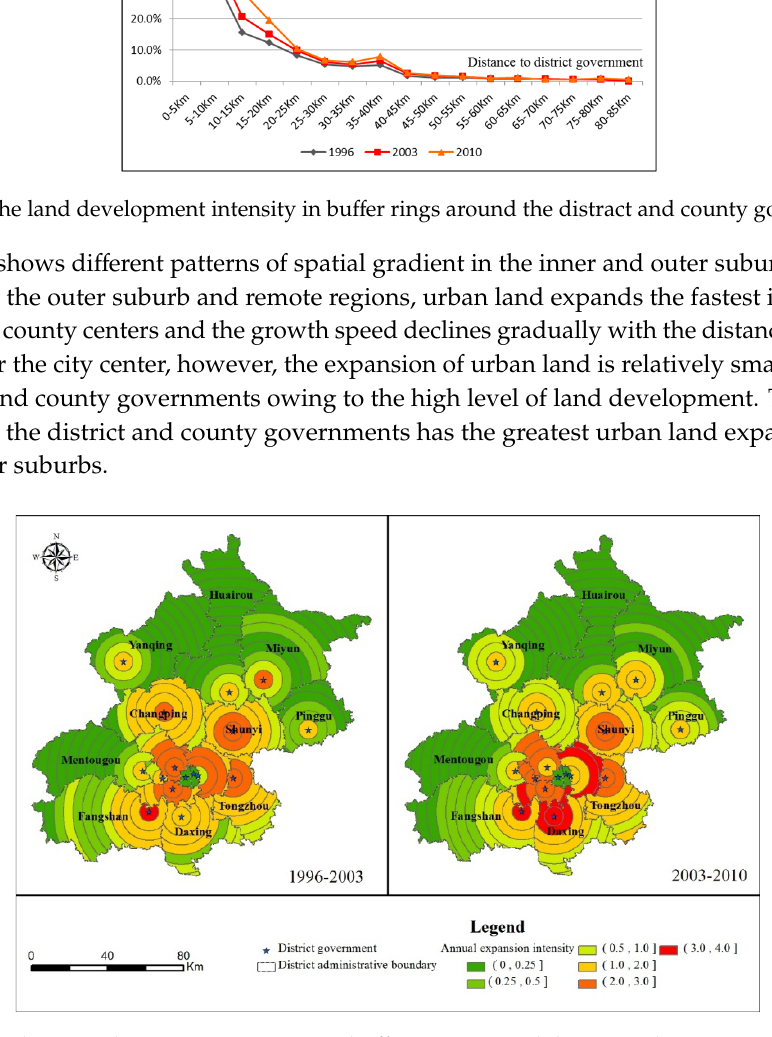
Figure 8. Land development intensity in buffer rings around the district and county governments.